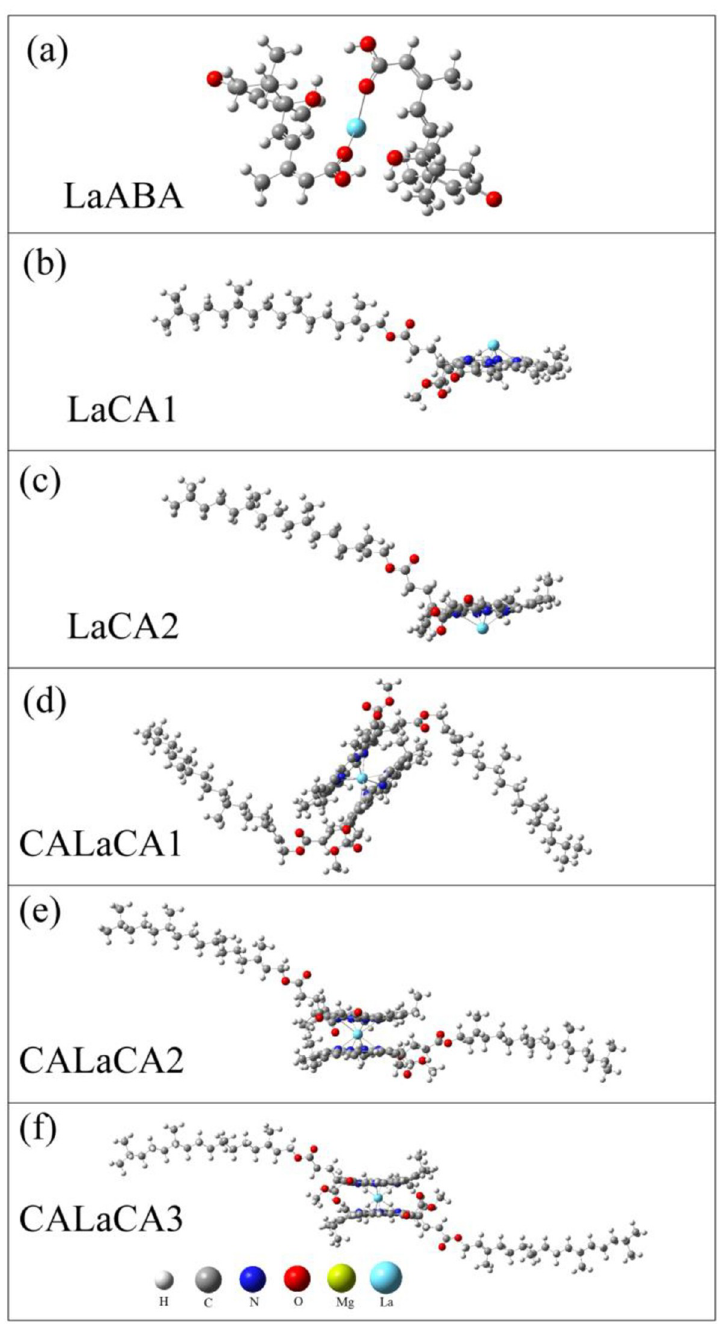
Fig 4. Optimized structures for the reactions between La, ABA and Mg-chlorophyll A. (a) LaABA compound, (b-c) La-monochlorophyll A compounds (LaCA1 and LaCA2), and (d-f) sandwich-type La-bischlorophyll A compounds (CALaCA1, CALaCA2, and